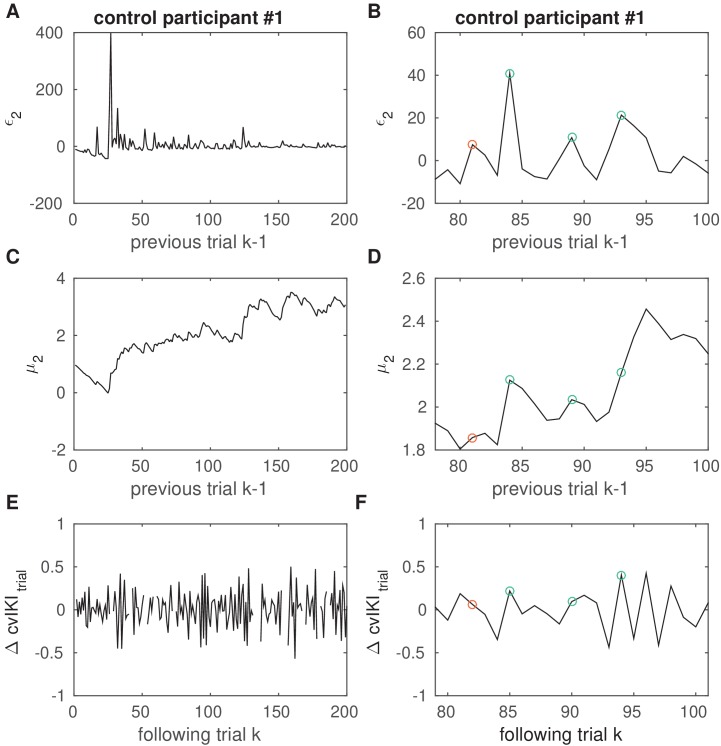
Example in one control participant of the association between pwPEs and performance.Example in one control participant of the association between pwPEs relating to volatility and subsequent changes in performance. (A, B) Illustration of the trajectory of pwPE relating to volatility on trial k-1, ϵ2k-1. Right panels are an enlarged display of a section of the corresponding left panel. (C, D) Trajectory of the expectation on log-volatility, μ2k-1. (E, F) Performance measure in the winning response model, Δ⁢cvIKItrialk, representing the change from trial k-1 to k in the task-relevant performance variable associated with reward, cvIKItrialk. Green circles denote trials of large values of ϵ2 that were followed by an increment in the performance measure (larger behavioral change). This figure illustrates the effect of positive β2 coefficients in the response model in control participants, linking large ϵ2 values to large changes in behavior on the next trial. Red circles mark trials of large ϵ2 values that led to smaller changes in the performance variable in the subsequent trial.